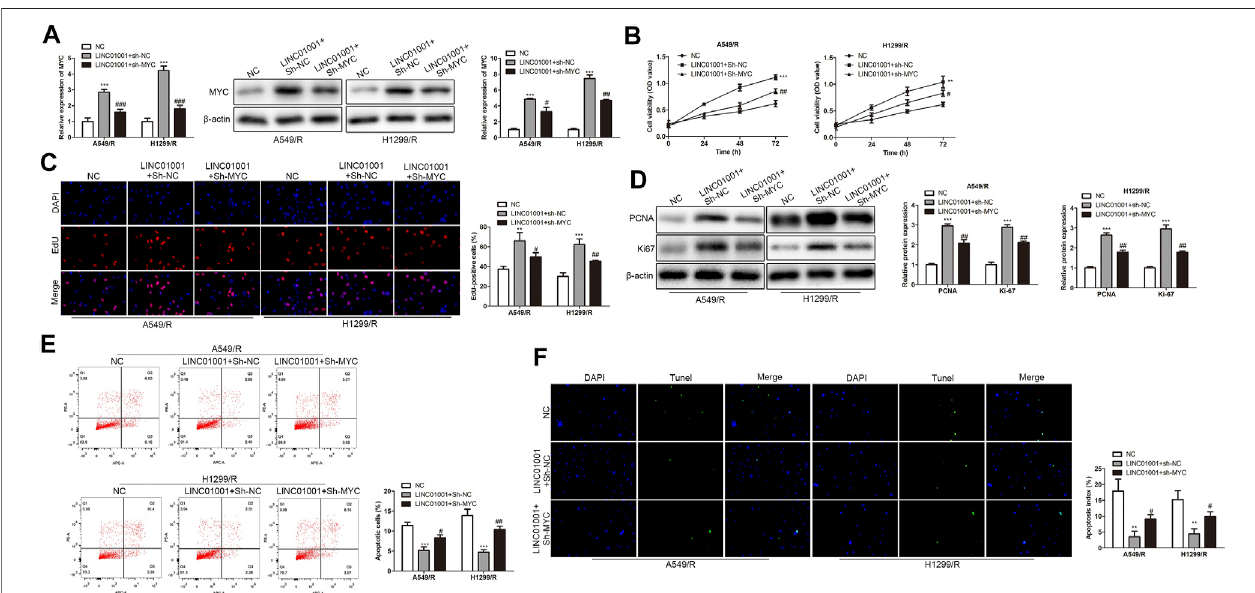
FIGURE 8 | LINC01001 overexpression increases crizotinib-resistance of NSCLC cells via MYC. (A) RT-qPCR and western blot detected the level of MYC. (B) CCK-8 assay assessed the viability of crizotinib-resistant NSCLC cells. (C) EdU assay evaluated the proliferation of crizotinib-resistant NSCLC cells. (D) Western blot examined the level ofproliferation-related proteins. E, FACs detected apoptosis ofcrizotinib-resistant NSCLC cells. F, TUNEL assessed apoptosis of crizotinib-resistant NSCLC cells. ** p < 0.01, *** p < 0.001 vs NC group, # p < 0.05, ## p < 0.01, ### p < 0.001 vs LINC01001+sh-NC group. Error bars represent SD. Data represent three independent